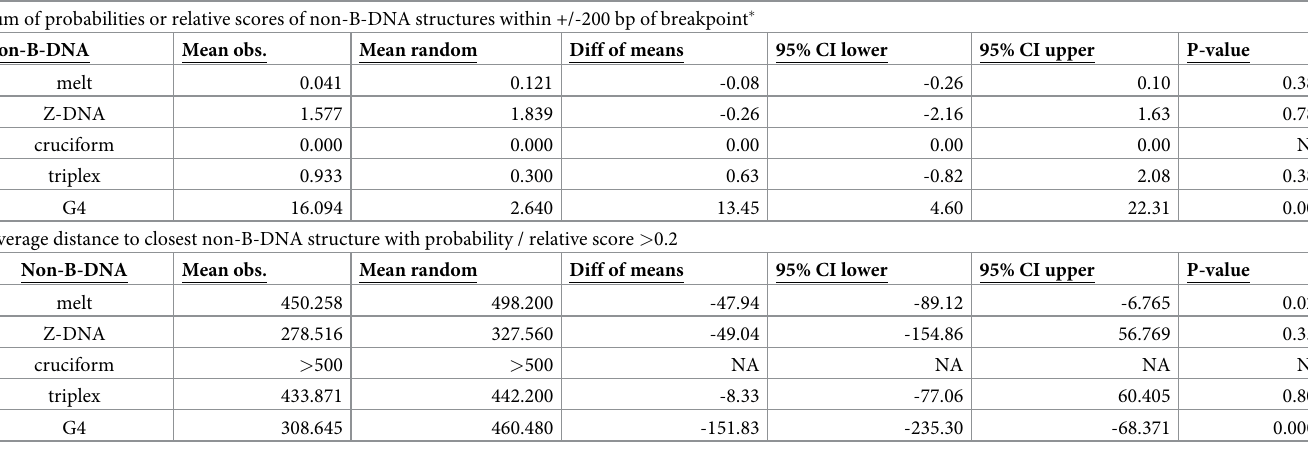
Table 3. P-values of non-B-DNA summed probabilities or scores, and distances to breakpoints. Sum of probabilities or relative scores of non-B-DNA structures within +/-200 bp of breakpoint � Non-B-DNA Mean obs.